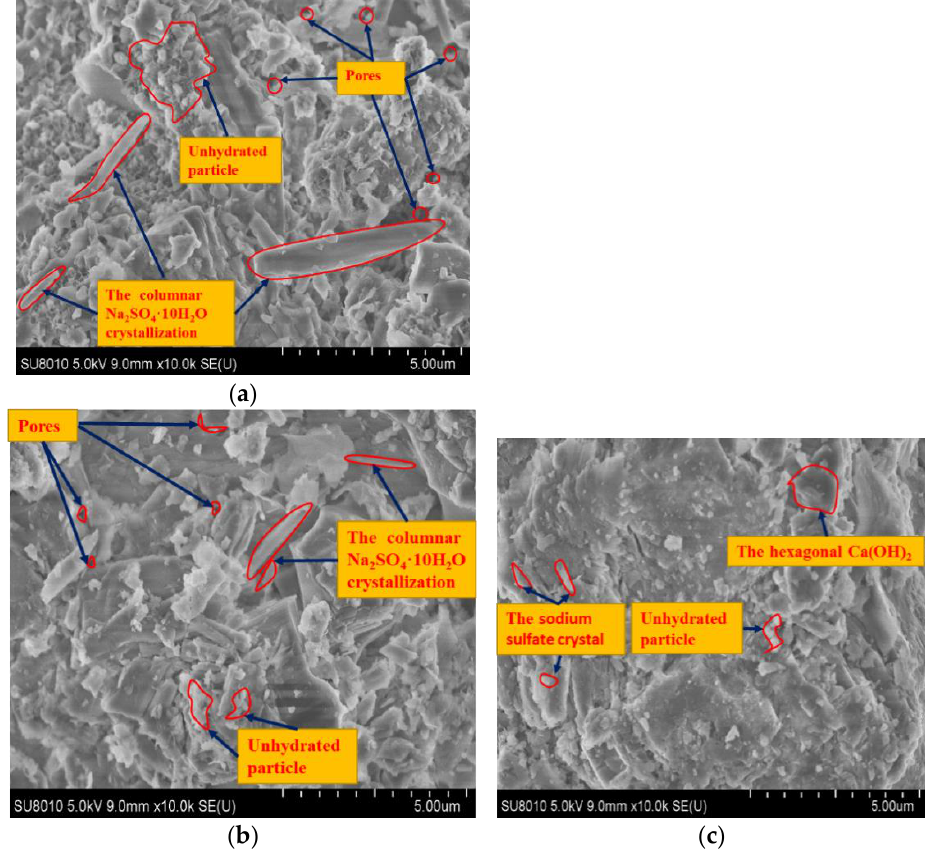
Figure 9. Scanning electron microscopy (SEM) image of specimens with different temperature. ( a ) Cement: 3%, sodium sulfate: 3%, temperature: 10 ◦ C. ( b ) Cement: 3%, sodium sulfate: 3%, temperature: 20 ◦ C. ( c ) Cement: 3%, sodium sulfate: 3%, temperature: 35 ◦